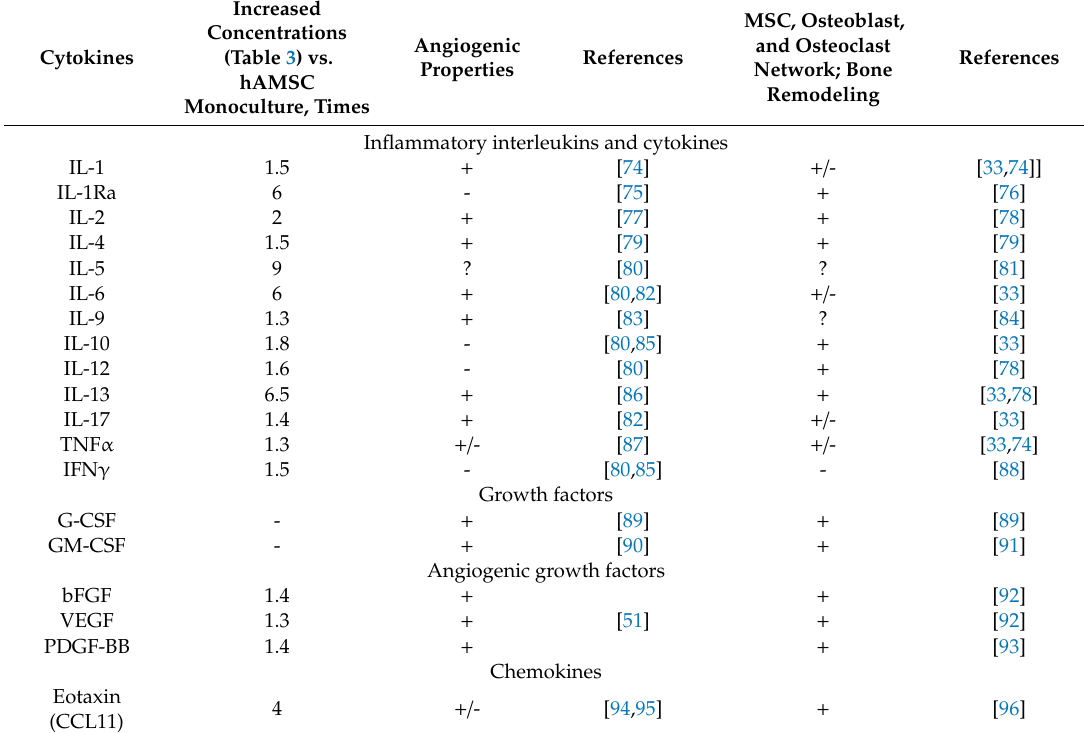
Table 5. Significant increases in cytokines, growth factors and chemokines with angiogenic and osteomodulatory potential in 14-day mixed hAMSC + hBMNC